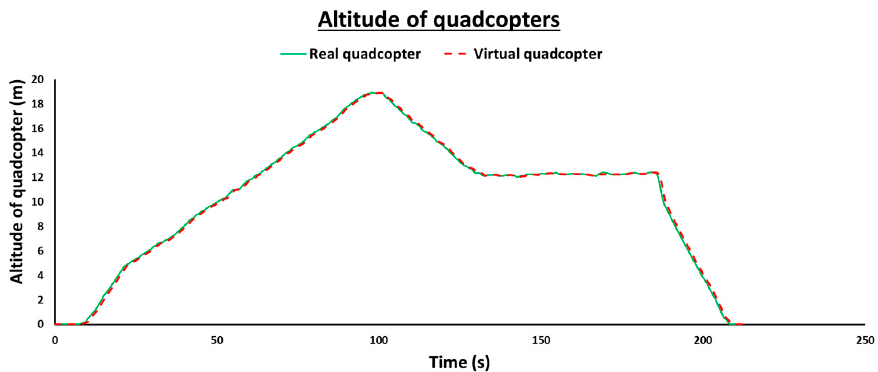
Figure 22. Longitude comparison of the real and the virtual quadcopters.